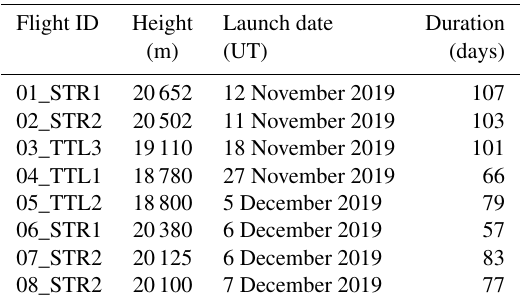
Table 1. Main characteristics of Strateole-2 C0 flights. All super- pressure balloons are equipped with TSEN (Thermodynamics SEN- sors)